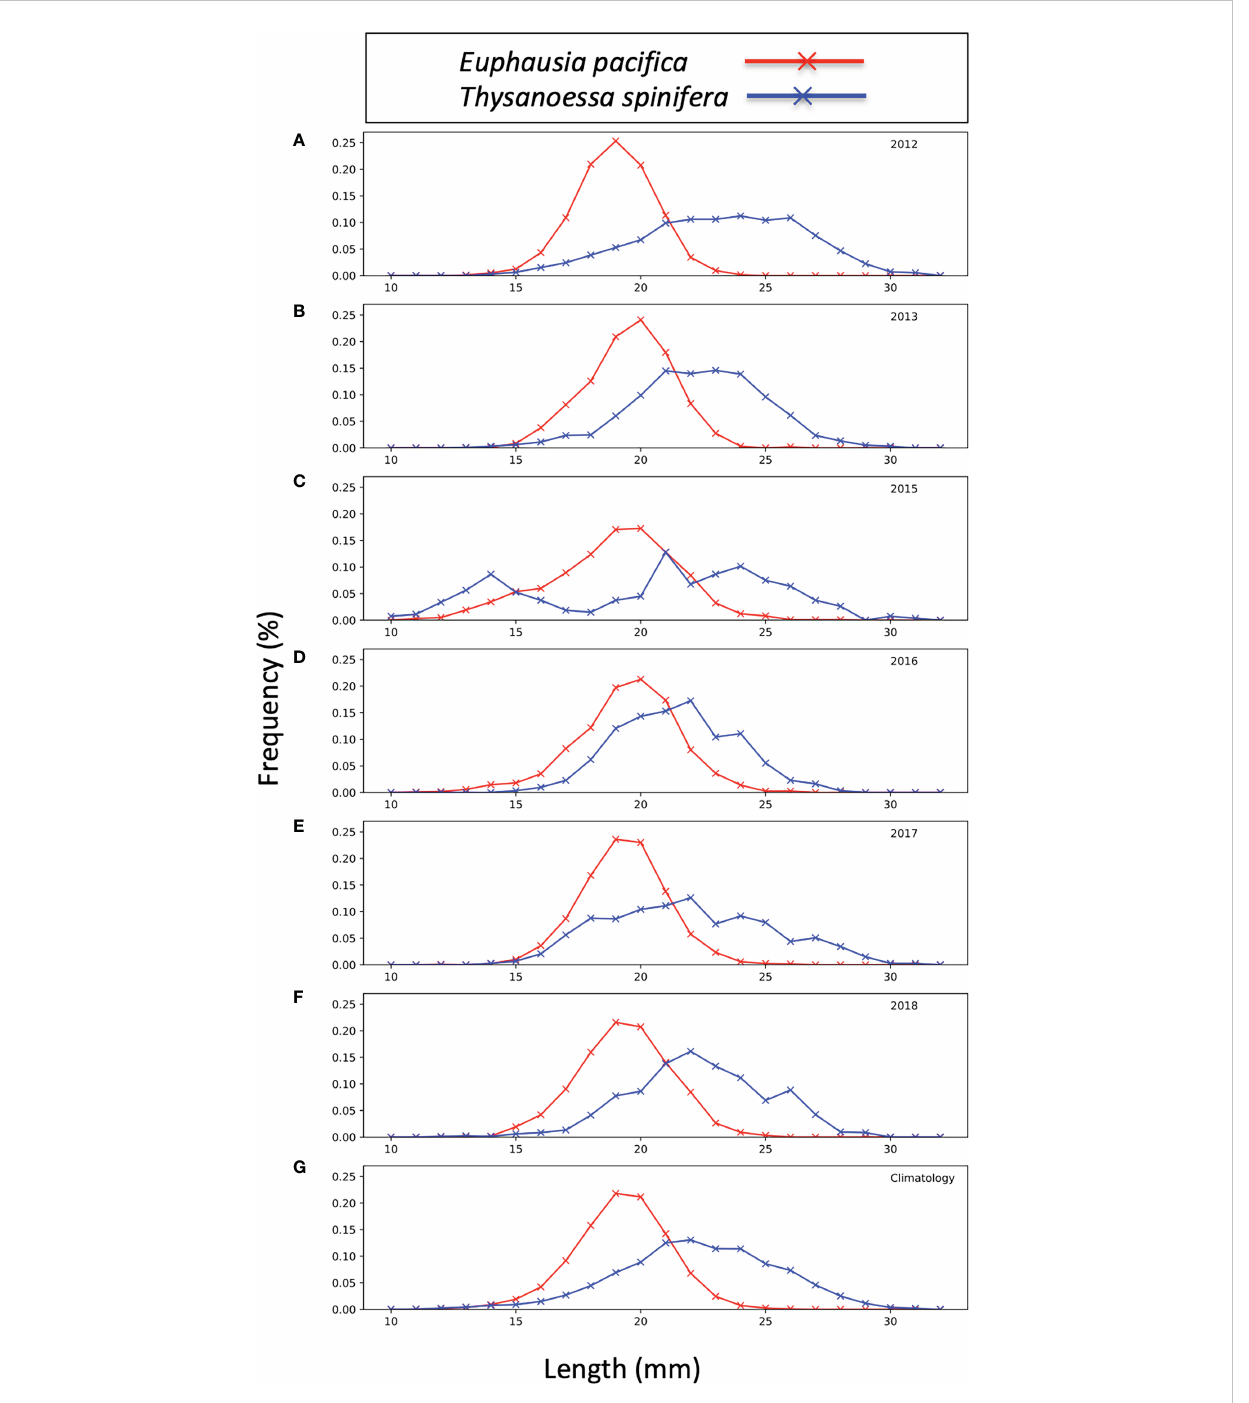
FIGURE 3 Euphausia paci fi ca (red) and Thysanoessa spinifera (blue) population size structure from 2012 – 13 (A, B) , 2015 – 18 (C – F) , and a combined climatology (G) . Frequency is the percentage of total measured species at each length increment